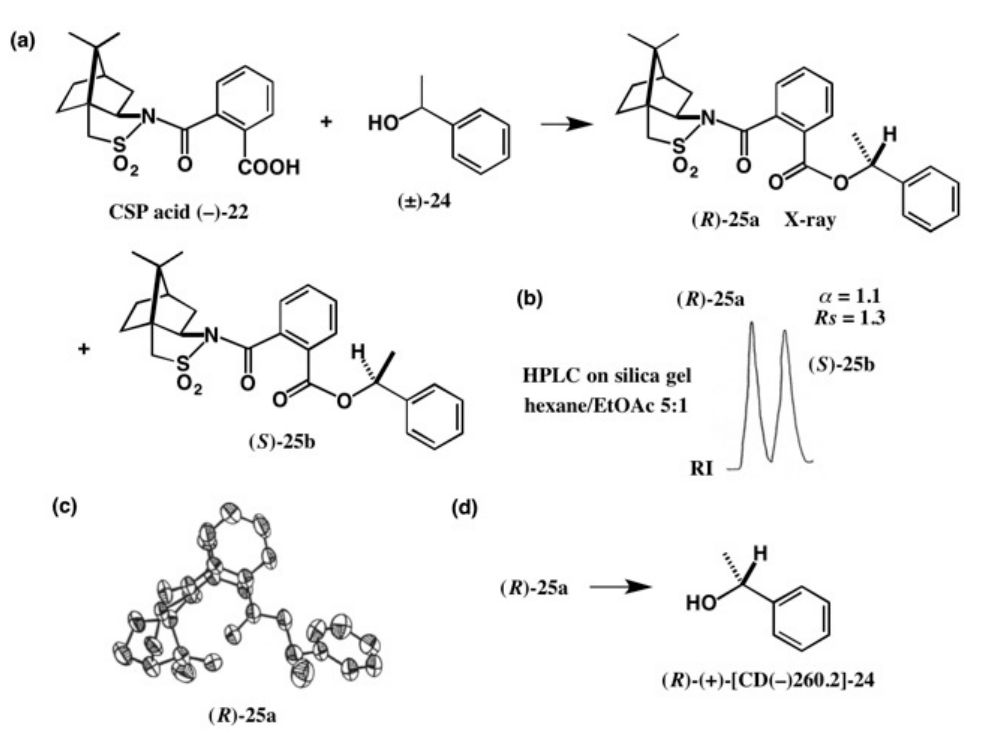
Figure 17. Preparation ( a ) and HPLC separation ( b ) of esters 25a and 25b , and the AC determination of ester ( R )- 25a by X-ray analysis ( c ). From ester ( R )- 25a , alcohol ( R )-(+)- 24 was obtained ( d ). HPLC, redrawn from [32]. ORTEP drawing, reprinted from [31].